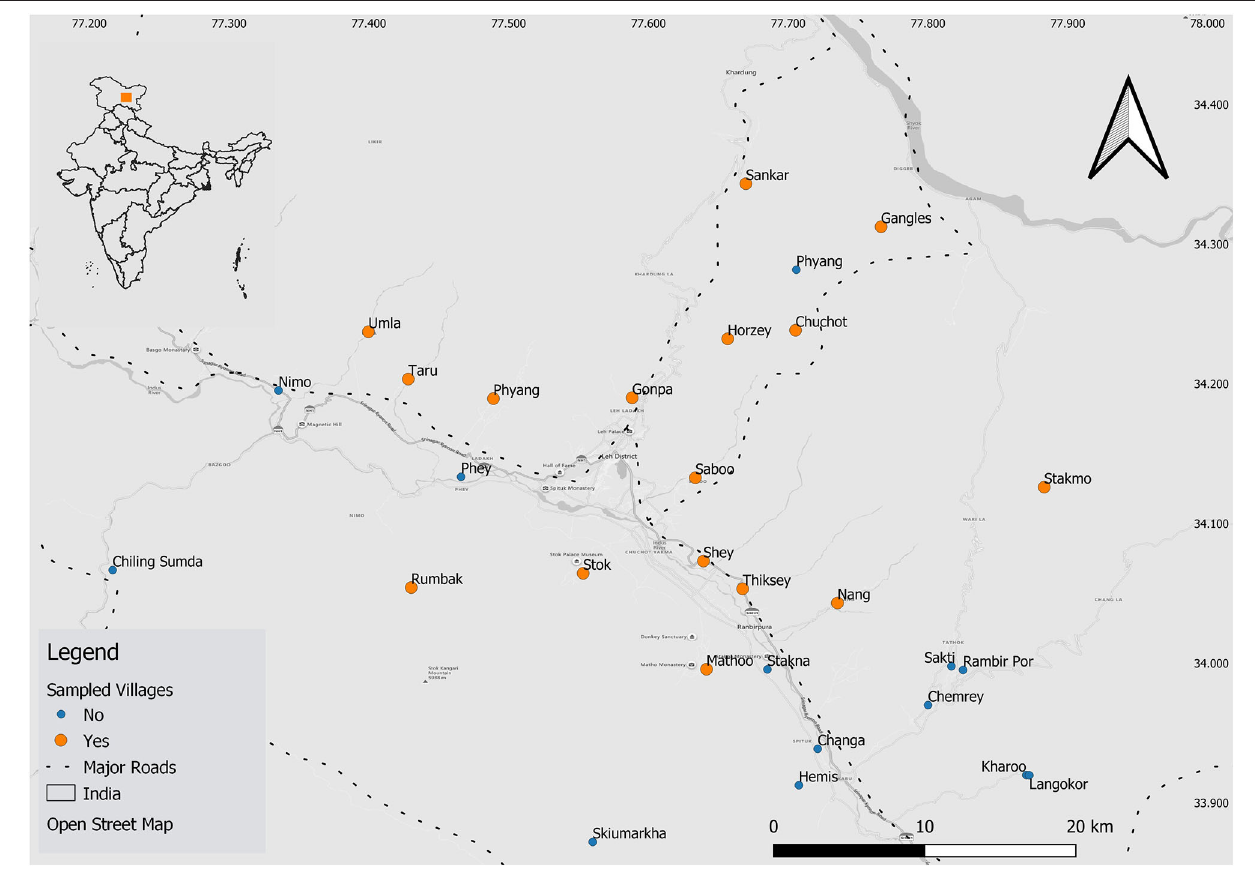
FIGURE 1 | Map of the study area showing the location of villages and villages surveyed in the Ladakh region. Map inset shows the location of the study area in the union territory of Ladakh,